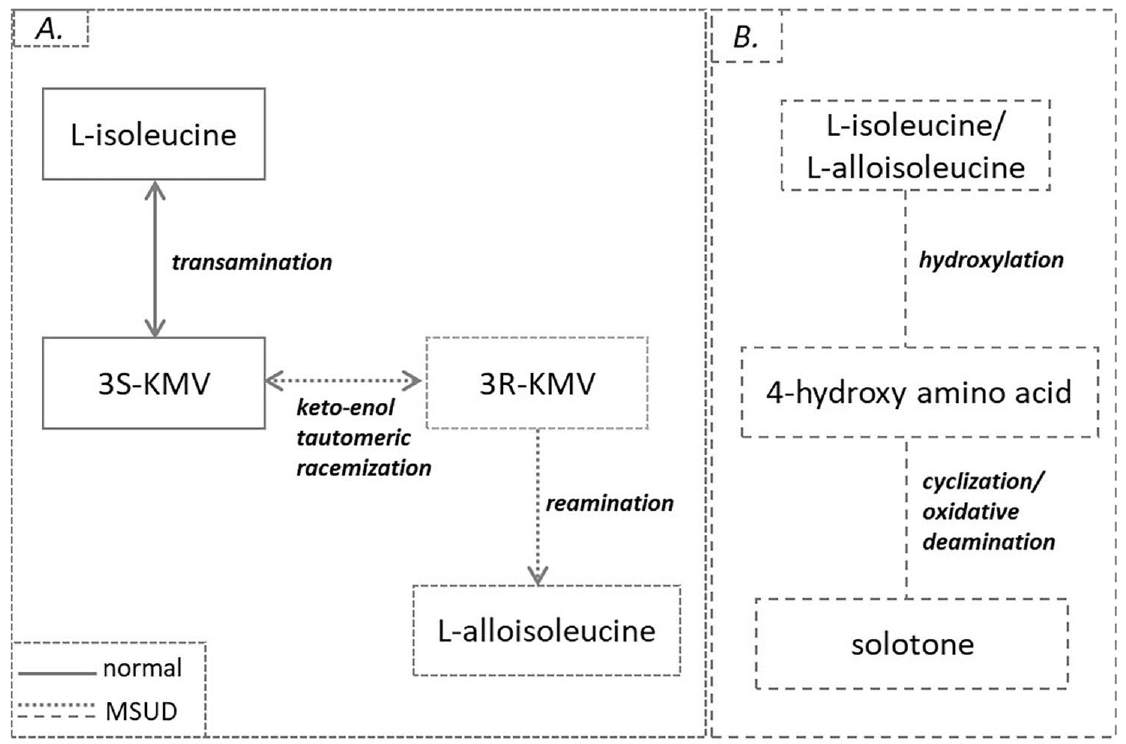
Figure 4. ( A ) L-alloisoleucine formation. ( B ) Solotone formation in